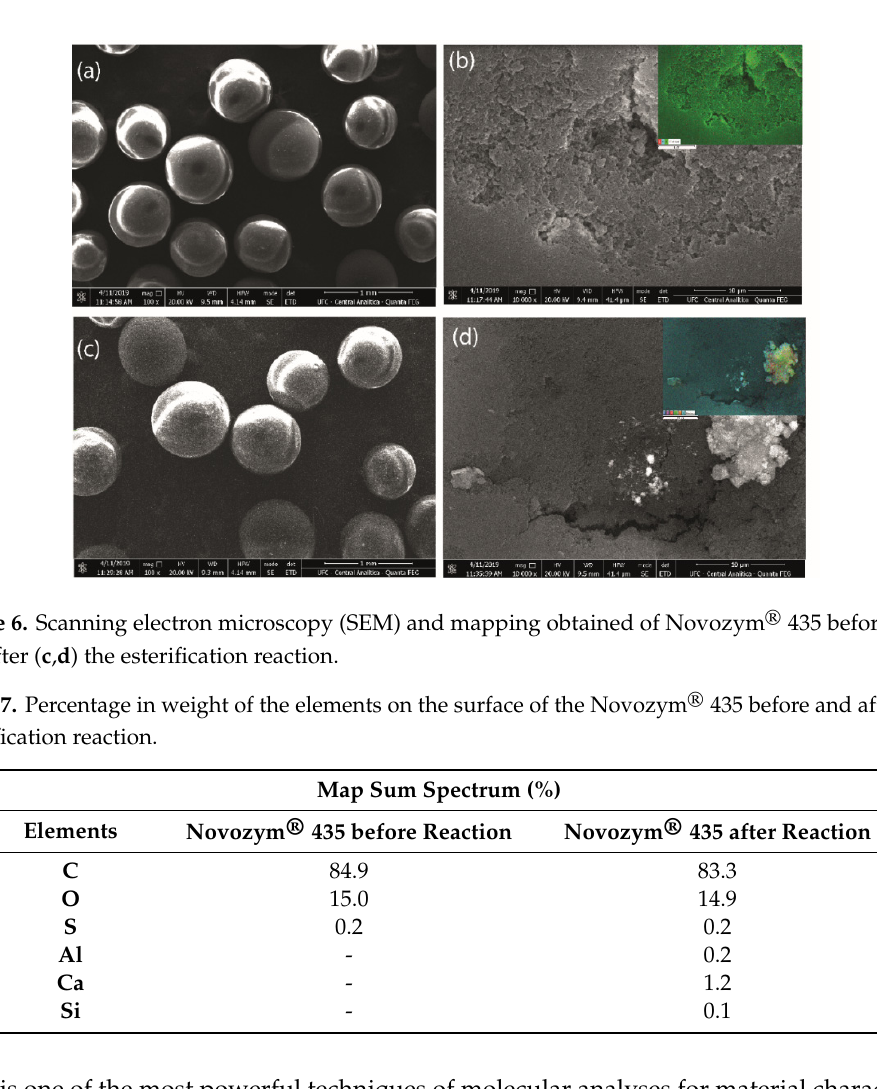
Figure 5. Fourier Transform Infrared ( FTIR) spectrum of the Novozym ® 435 before ( a ) and after ( b ) the esterification reaction.